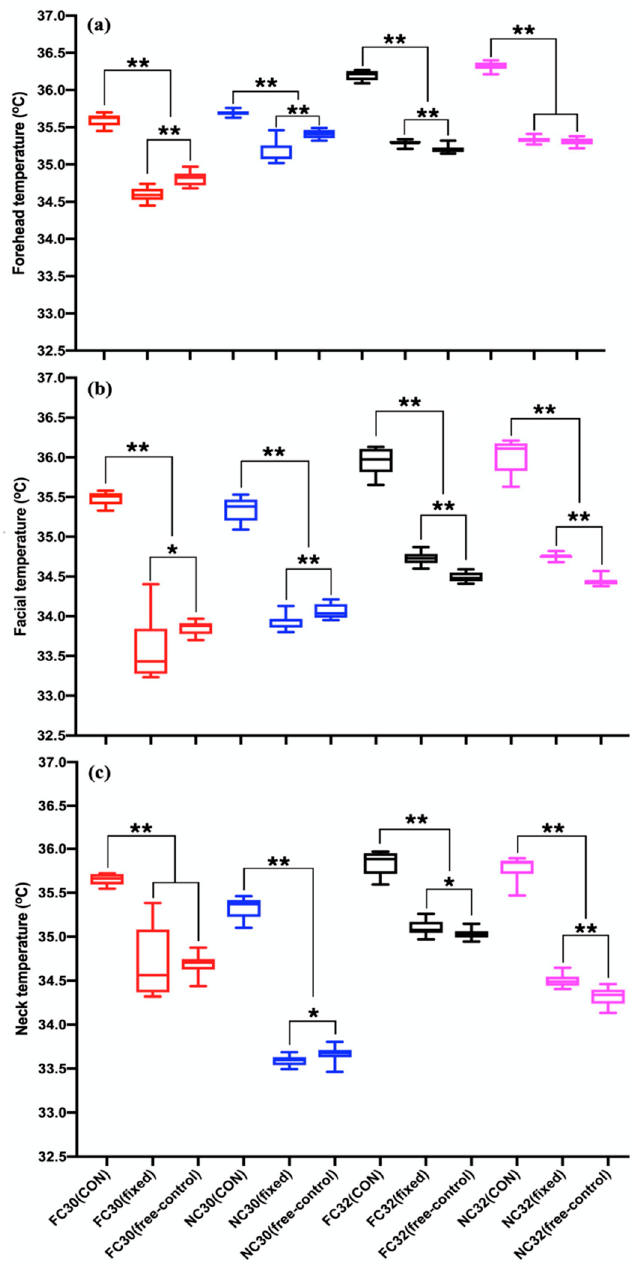
Figure 2. Local mean skin temperatures at the ( a ) forehead, ( b ) face and ( c ) neck of 12 studied test scenarios. *, p < 0.05; **, p < 0.001.